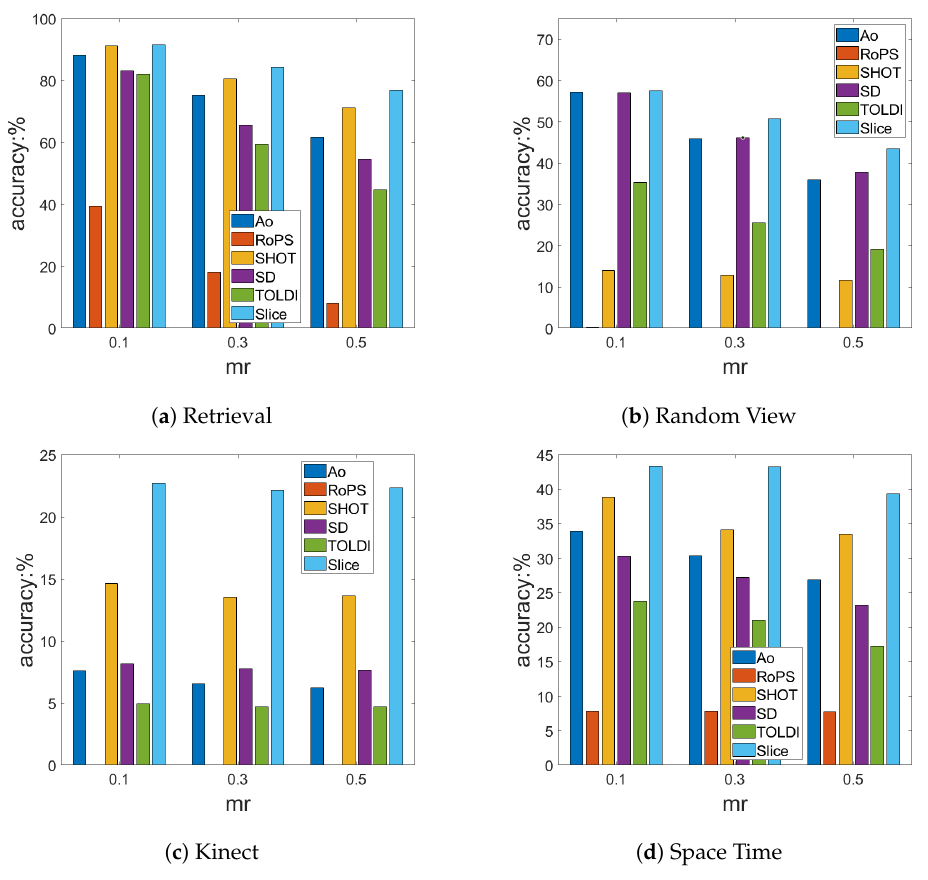
Figure 9. The Gaussian noise experiment results. The X-axis represents different noise levels, and the Y-axis represents the accuracy of the